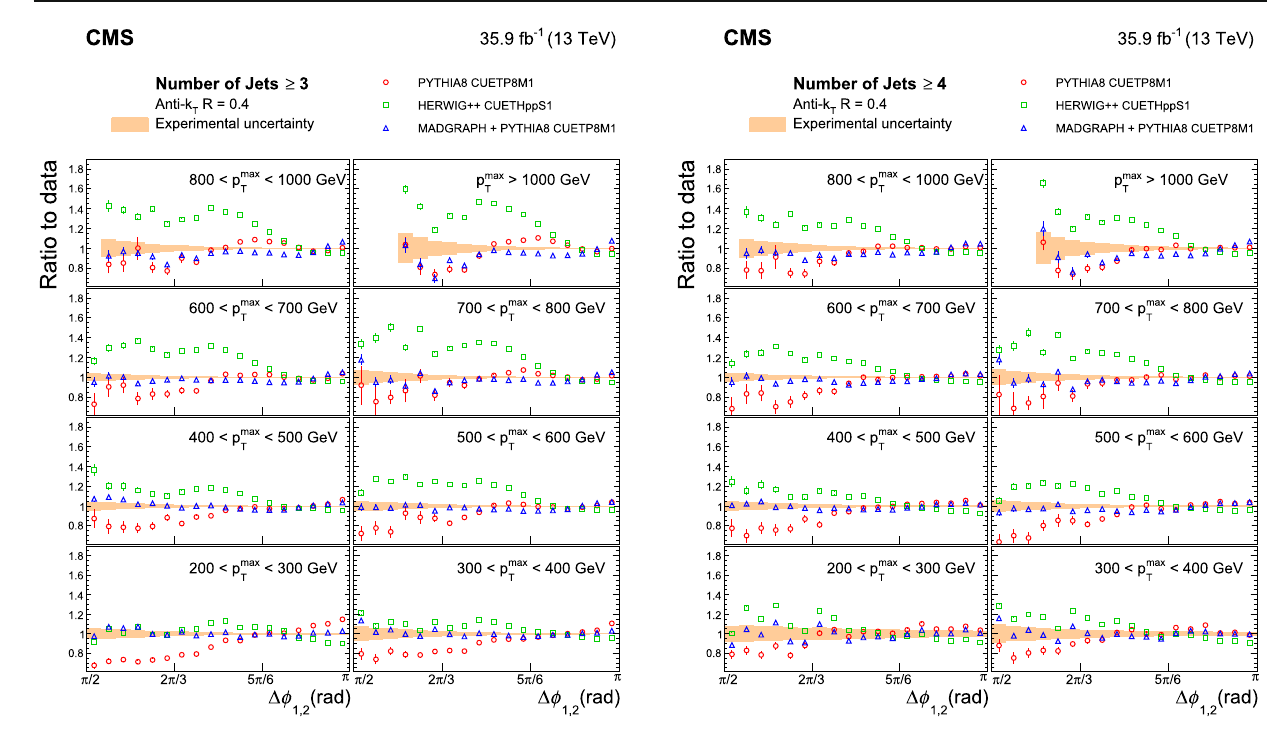
Fig. 5 Ratios of pythia 8, herwig++ , and MadGraph + pythia 8 predictions to the normalized inclusive 3-jet cross section differential in Δφ 1,2 , for all p max regions. The solid band indicates the total exper- T imental uncertainty and the vertical bars on the points represent the statistical uncertainties in the simulated data